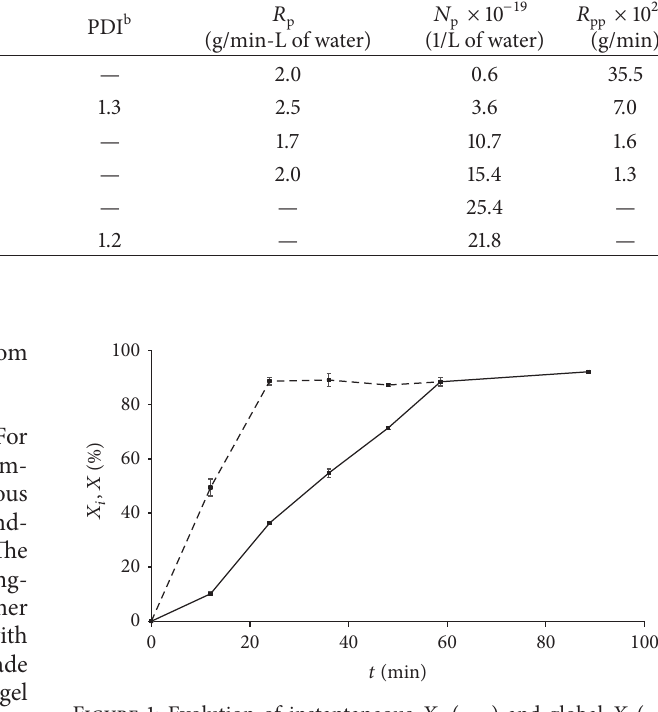
Figure 1: Evolution of instantaneous 𝑋 𝑖 (----) and global 𝑋 (—) conversions with time for the copolymerization of MMA/MAA (2/1,